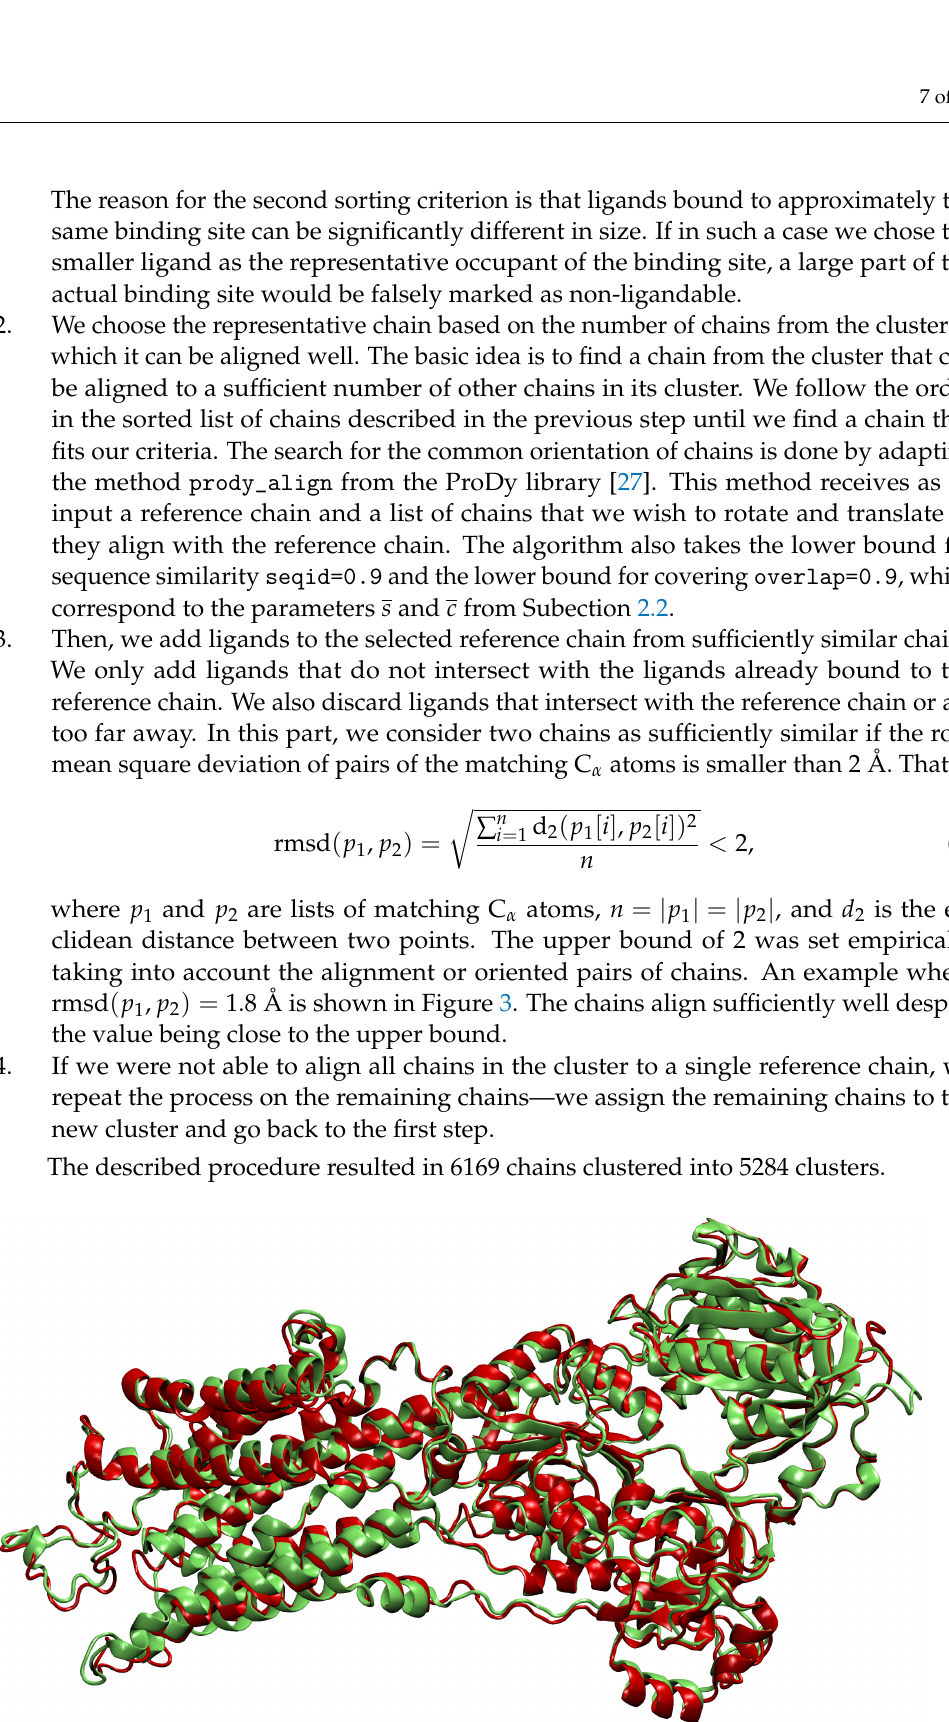
Figure 3. Oriented chains A from PDB files 2eat [28,29] (red) and 2eau [28,30] (green). The amino acid sequences of these two chains are identical. We see that in some areas the chains overlap very closely, but some deviation is allowed as well—for example, in the upper left helix. If we used a higher threshold for the rmsd distance, more deviation would be possible and, consequently, ligands would possibly be merged onto wrong locations. For visualization, we used the VMD software